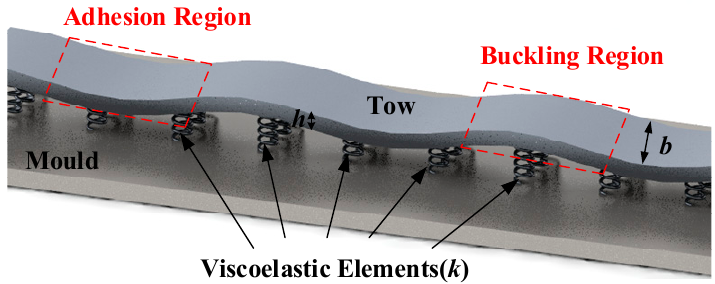
Figure 1. Diagram of the buckling model based on elastic foundation.